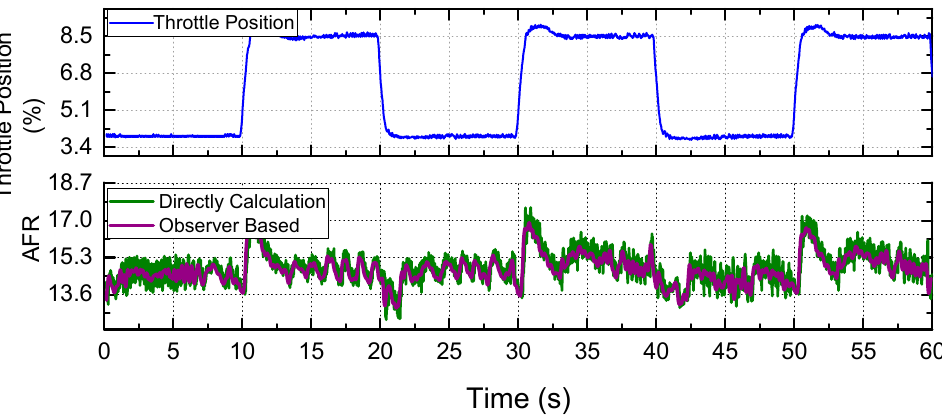
Figure 10. Experimental results of different intake air mass estimation.